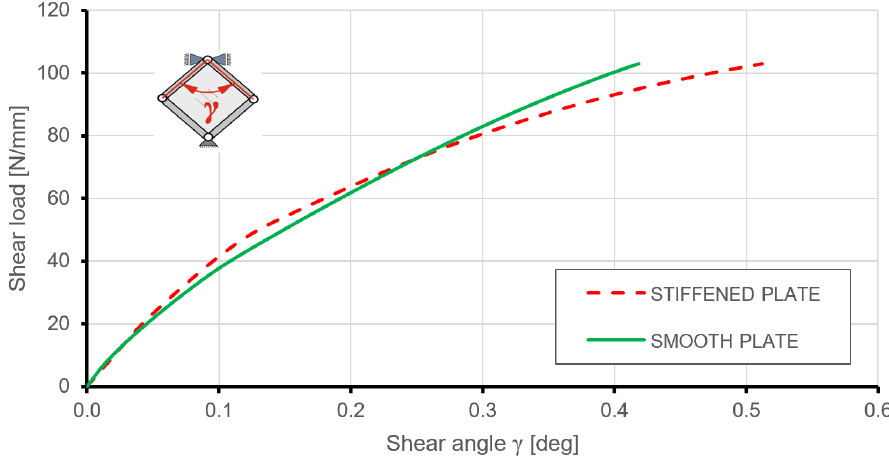
Figure 18. Comparison of shear load versus shear angle obtained from FEM for stiffened and smooth plates.